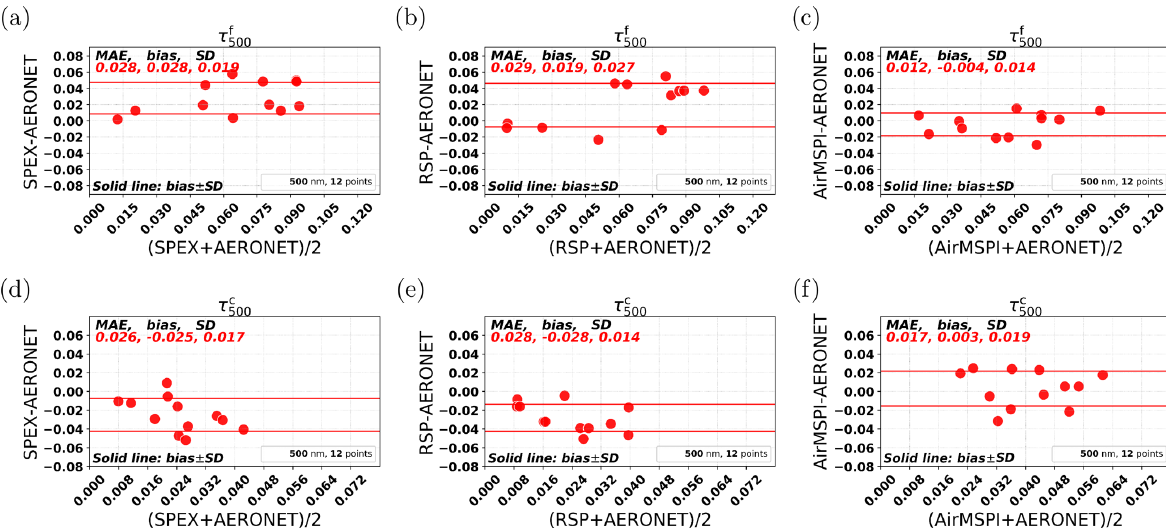
Figure 3. Comparison with AERONET for the AOD of the fine and coarse modes ( τ f and τ c ) among SPEX, RSP, and AirMSPI retrievals. 500 500 (a, b, c) Bland–Altman plots for τ f between SPEX and AERONET, between RSP and AERONET, and between AirMSPI and AERONET, 500 respectively. (d, e, f) Bland–Altman plots for τ c between SPEX and AERONET, between RSP and AERONET, and between AirMSPI and 500 AERONET, respectively.